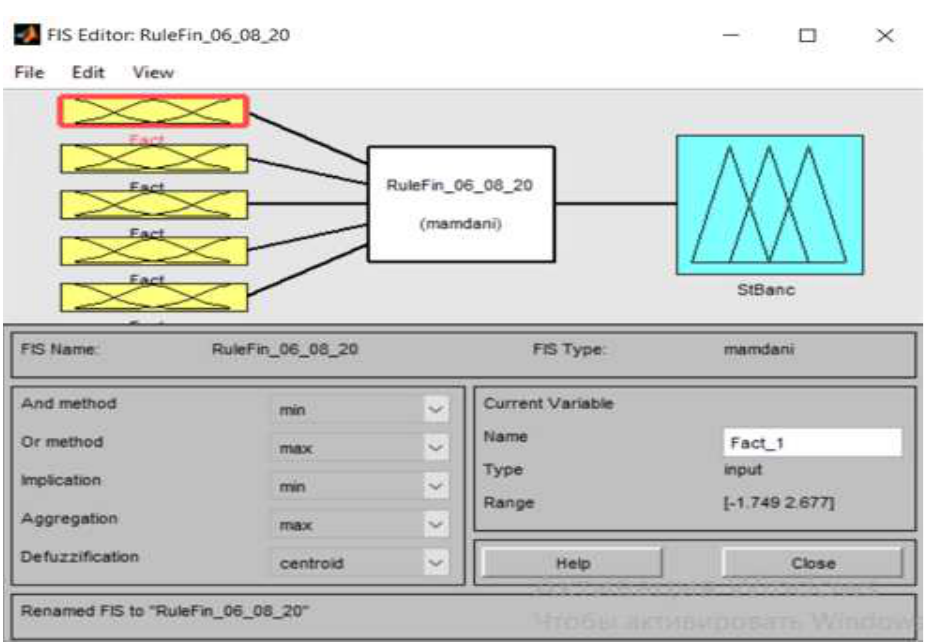
Figure 2. The Mamdani model constructed